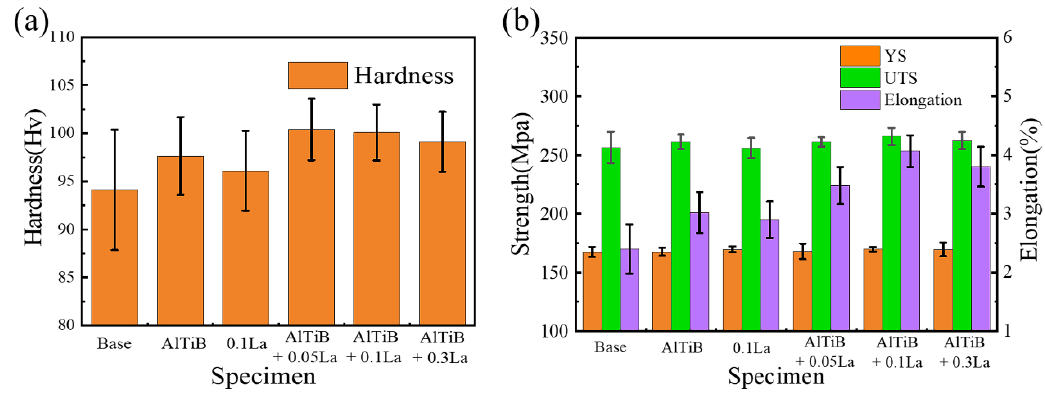
Figure 6. As cast mechanical properties ( a ) hardness test; ( b ) tensile properties.